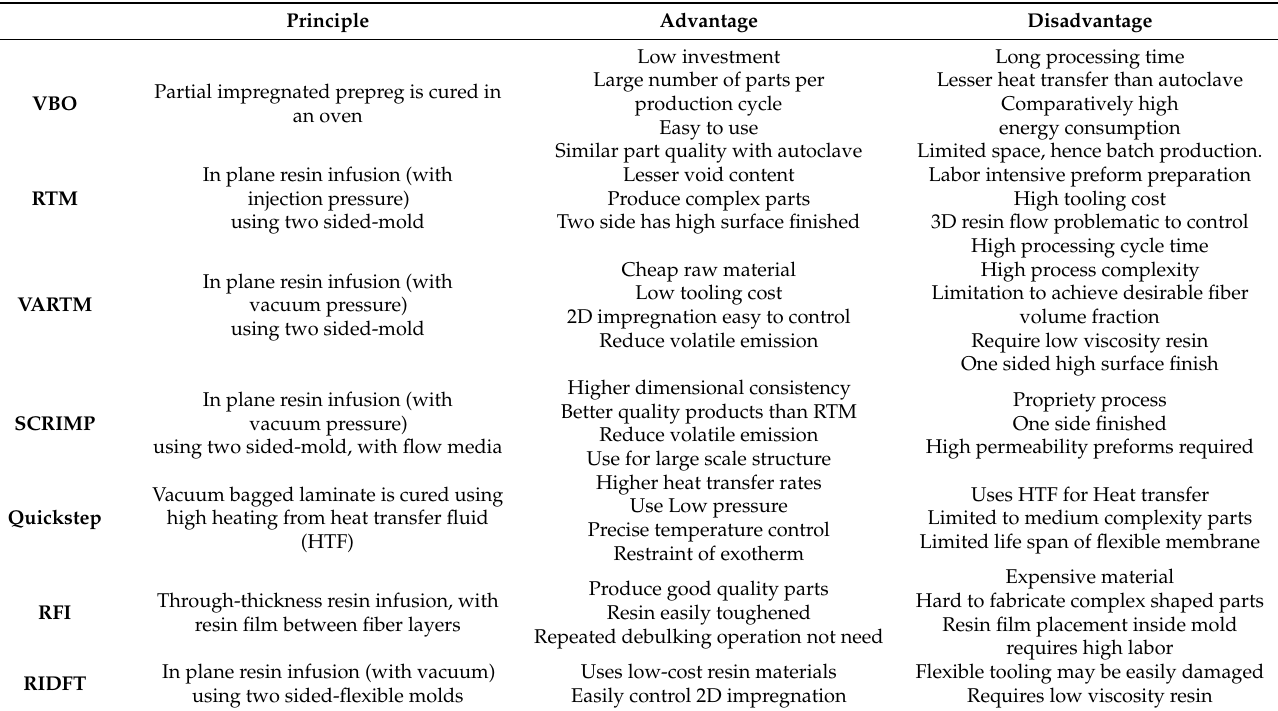
Table 6. OoA manufacturing